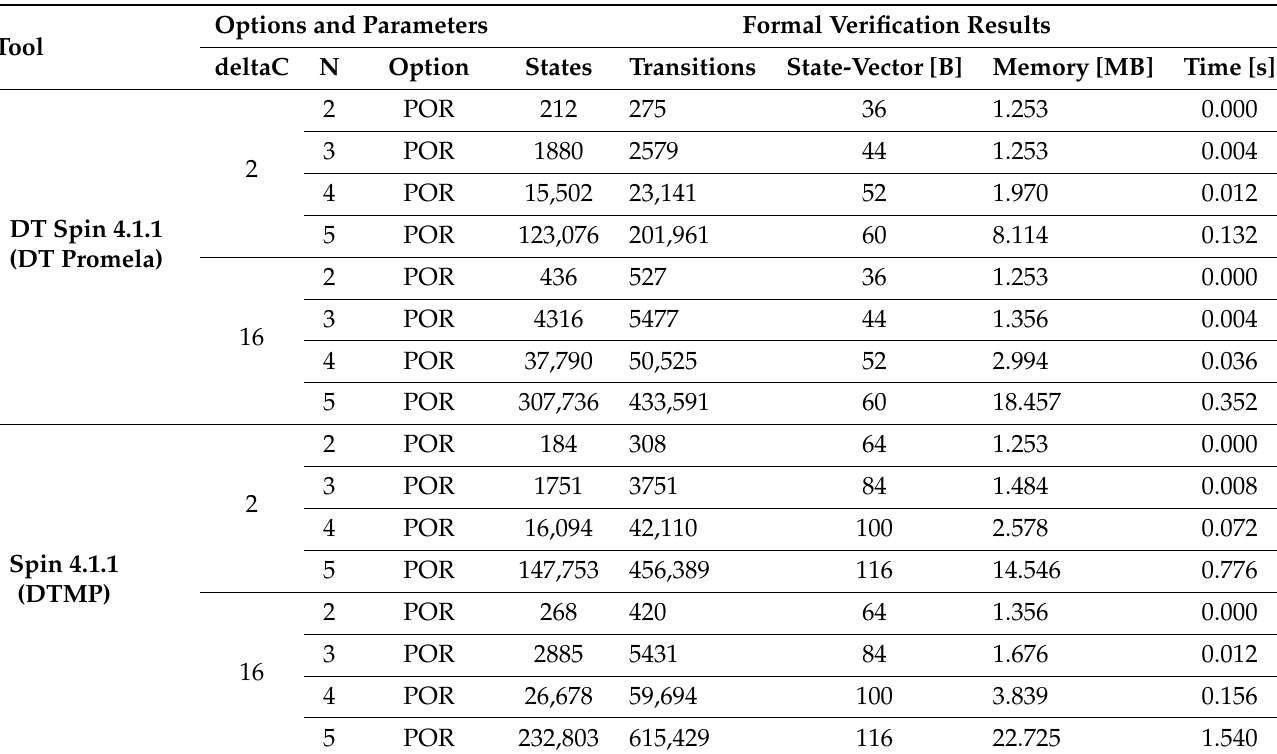
Table 1. Results for Fischer’s Mutual Exclusion Protocol for DP Promela and